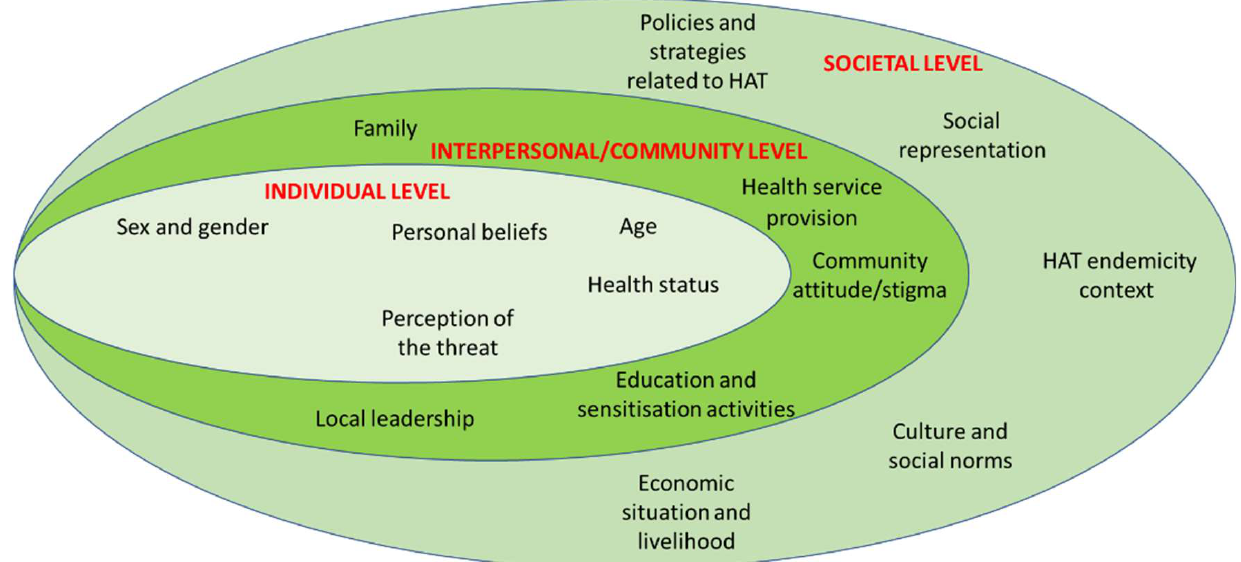
Figure 3. Factors influencing HAT related behaviors: Socio-ecological model. Adapted from Grand- Figure 3. FactorsinfluencingHATrelatedbehaviors: Socio-ecologicalmodel. ner, M. A. (2019) [27].